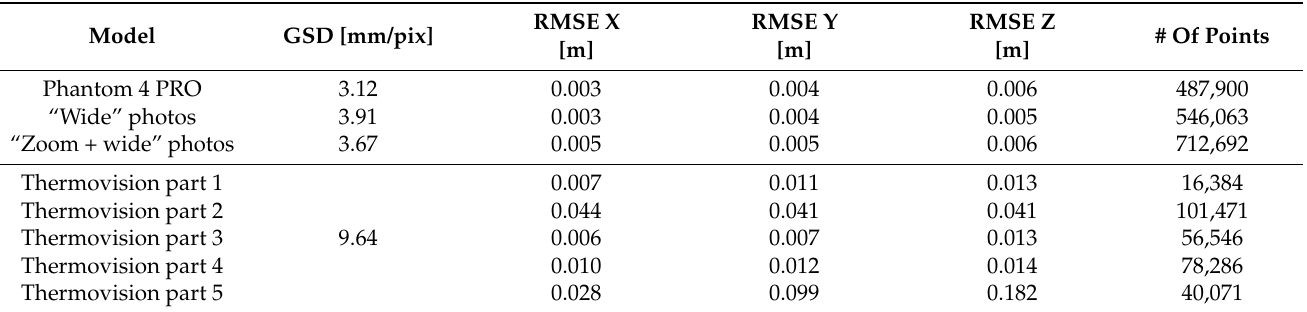
Table 5. Dense clouds